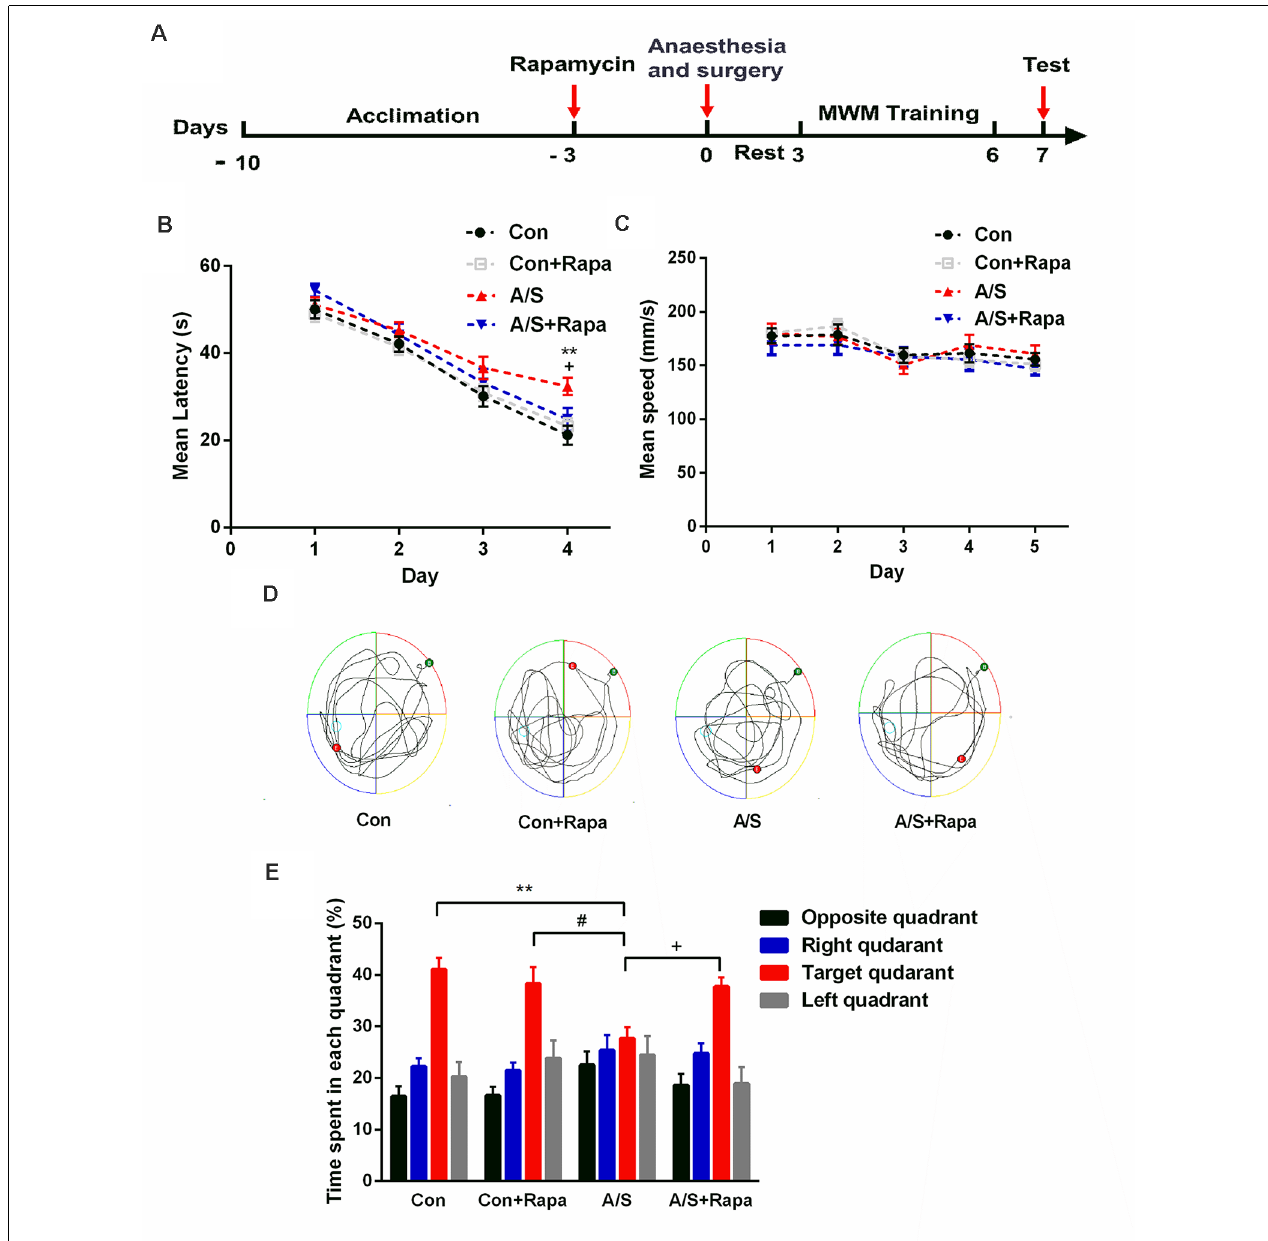
FIGURE 7 | Pretreatment with rapamycin alleviated the effects of anesthesia/surgery on reference memory in aged mice. (A) Schematic timeline of the experimental paradigm of surgery procedure and MWM test. After 3 days treatment with rapamycin, exploratory laparotomy was performed, training was conducted for 4 days followed by probe tests on day 7. (B) Escape latency to reach the hidden platform during the 4-day training; rapamycin reversed anesthesia/surgery-induced increase in escape latency. (C) Average swimming speed; there was no significant difference among the three groups. (D) Representative exploratory path of four groups of mice in the probe test. (E) The percentage of time spent in the target quadrant during the probe test; rapamycin reversed anesthesia/surgery-induced decrease in time spent in the target quadrant. Data are mean ± SEM ( n = 12 per group). ** p < 0.01 vs. Con. # p < 0.05 vs. Con+Rapa. + p < 0.05 vs. A/S. Con, control group; Con+Rapa, control group with rapamycin pretreatment; A/S, anesthesia/surgery group; A/S+Rapa, anesthesia/surgery group combined with rapamycin